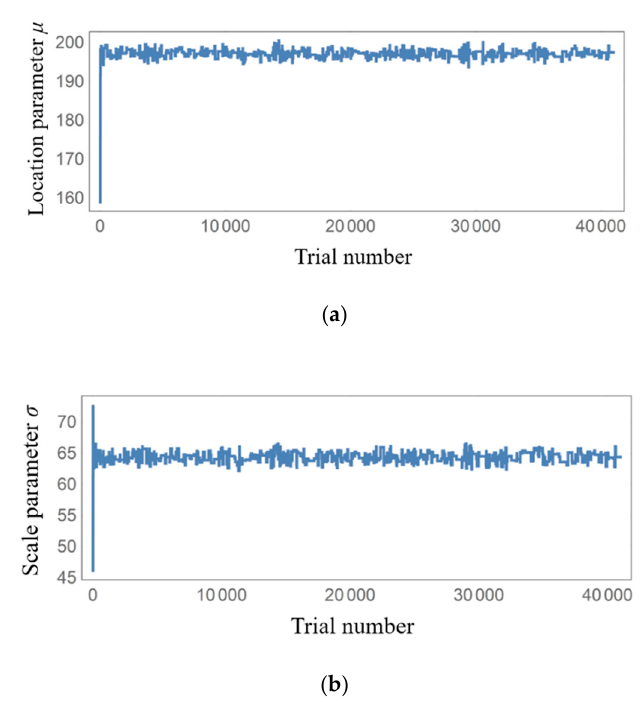
Figure 10. Sample parameter series of posterior distribution of Gumbel distribution fitted to the analytical data generated by the Metropolis method. ( a ) Location parameter μ ; ( b ) Scale parameter σ .